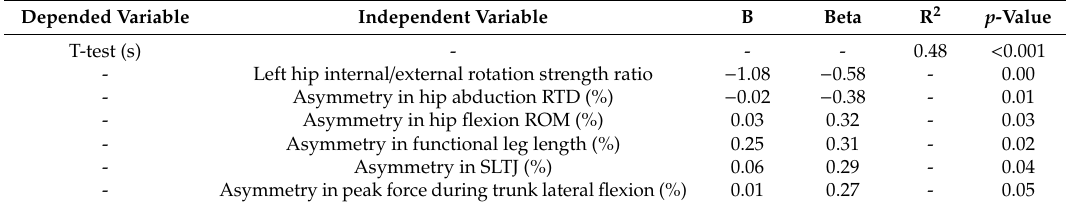
Table 5. Final regression model with six independent variables (dependent